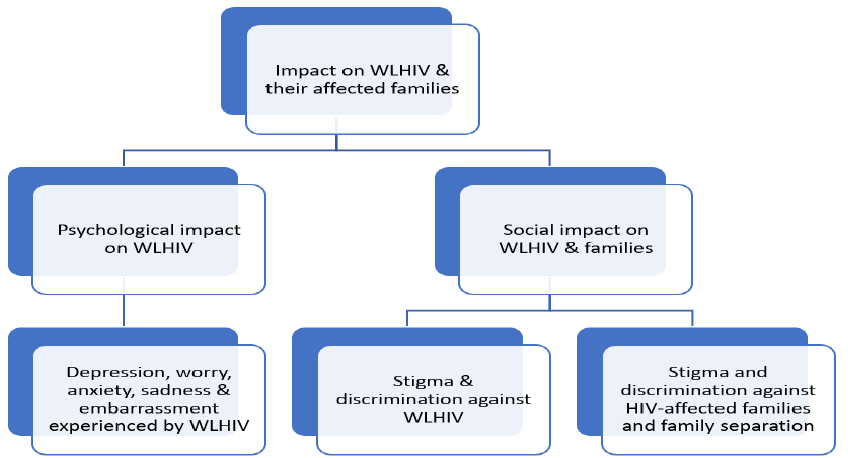
Figure 2. A simplified conceptual model for the psychological and social impacts of HIV on individuals and families.